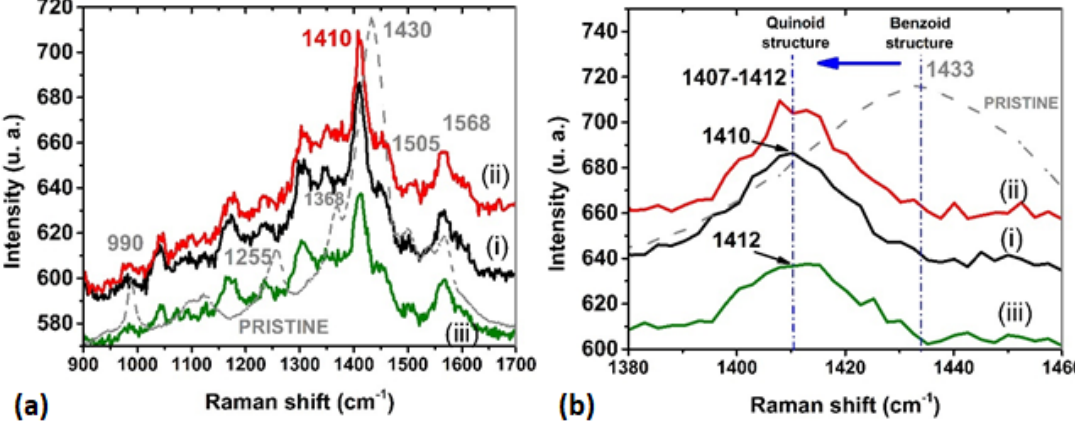
Figure 5. ( a ) Raman spectra of (i) PEDOT:PSS-CoP, (ii) PEDOT:PSS-CuP, (iii) PEDOT:PSS-PdP composite films and PEDOT:PSS pristine; ( b ) Close view of Raman associated to C=C symmetrical stretching intramolecular vibration (1400–1440 cm − 1 ) and shift from benzoid to quinoid structure.